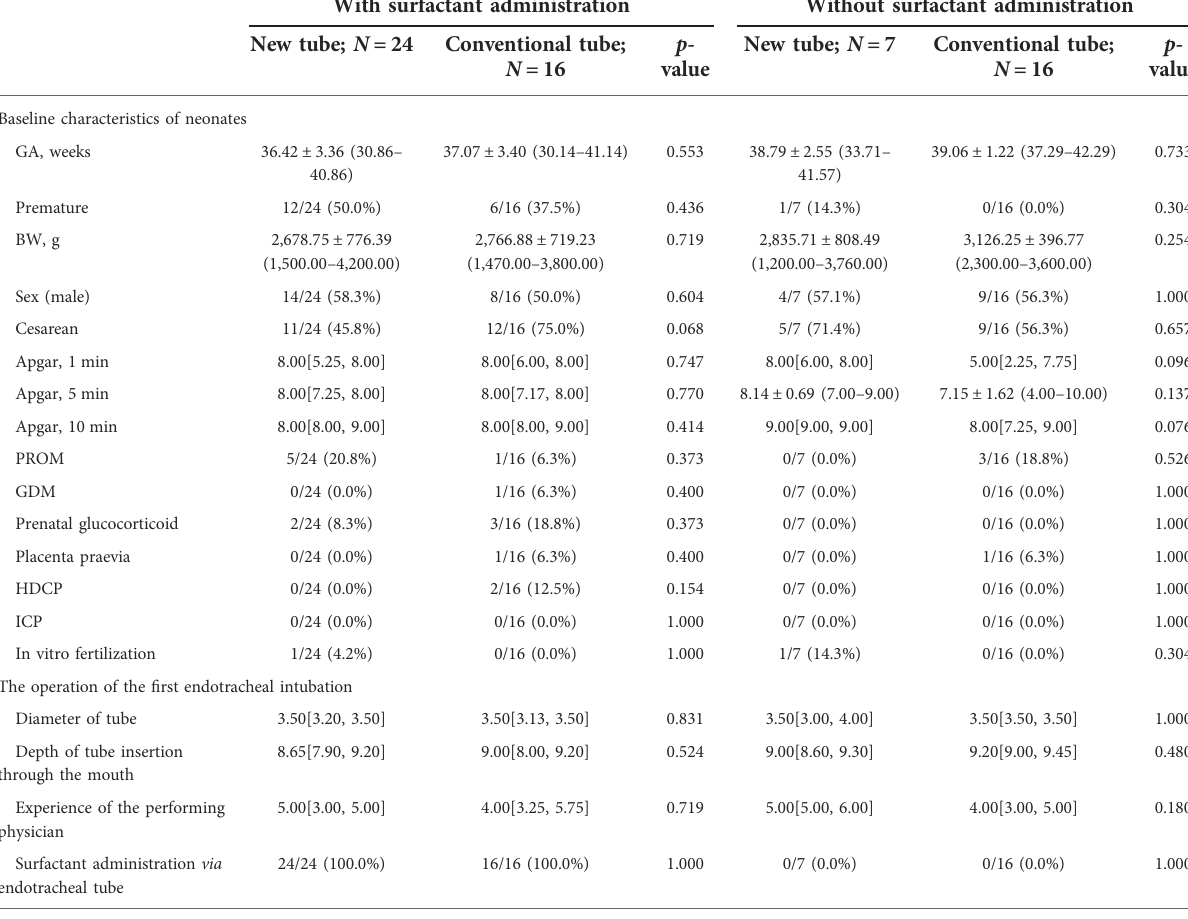
TABLE 4 Basic information on mechanically ventilated neonates with and without surfactant administration via endotracheal